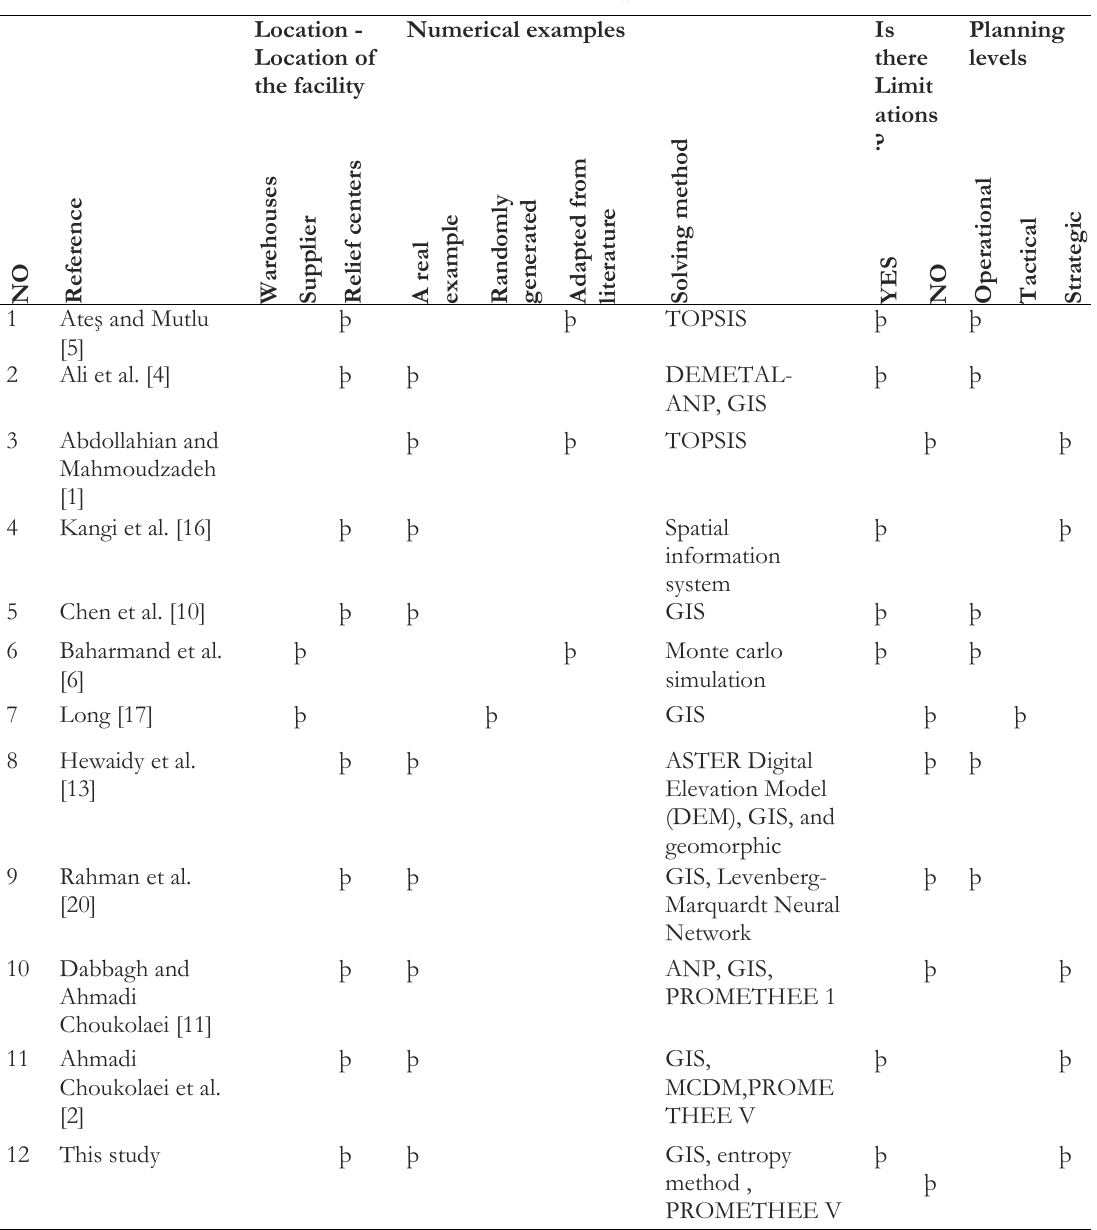
Table 1. Literature review